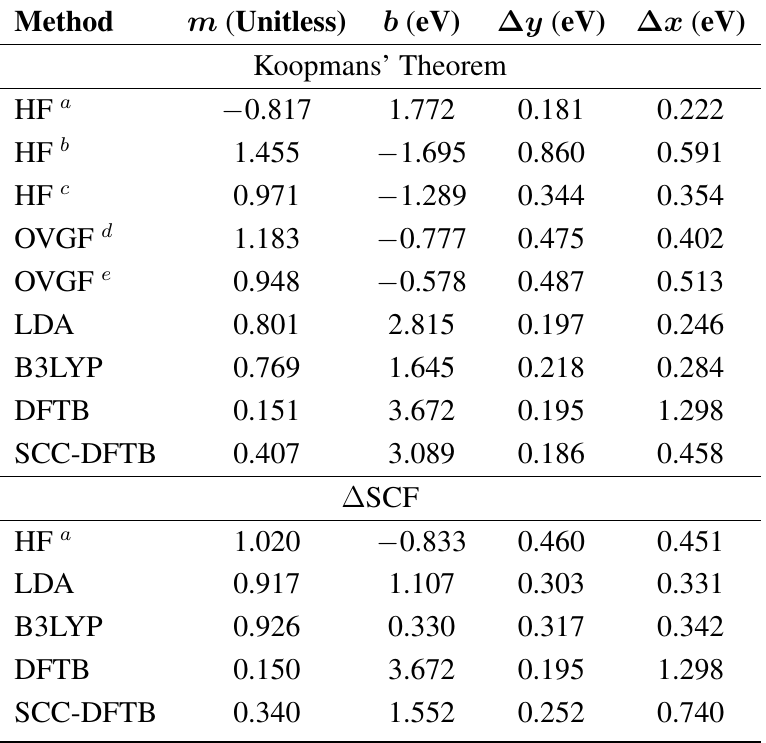
Table 8. Fitting data for first EAs of the medium-sized benchmark dataset (BDS) molecules: y = mx + b , where x is the GW EA and y is another theoretical EA, both in eV. HF, Hartree–Fock; OVGF, outer valence Green’s function; LDA, local density approximation; DFTB, density-functional tight binding (without self-consistent charge); SCC-DFTB, self-consistent charge